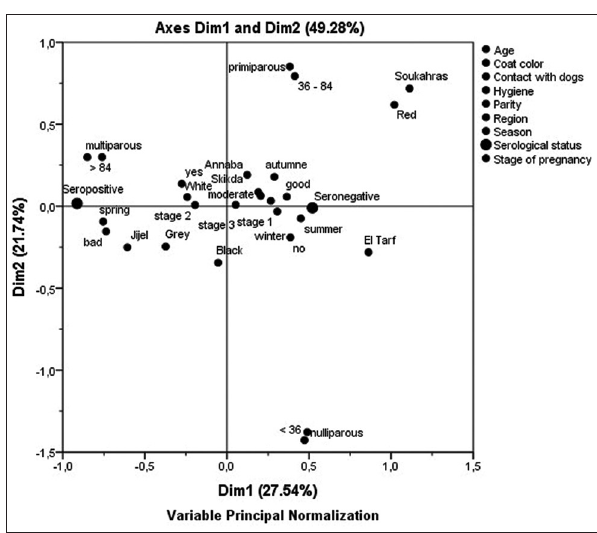
Figure-2: Plot of multiple correspondence analysis related to factors associated with seroprevalence of Neospora caninum . Table-3: Association between seroprevalence and abortion at the farms level. Test Case farm